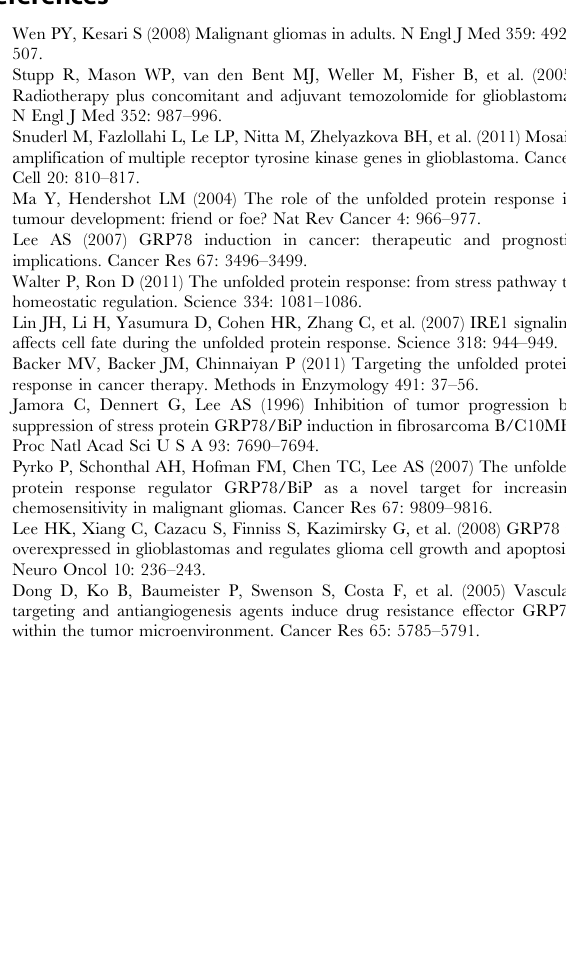
Figure S3 Effect of EGF SubA and SubA on cell pro- liferation. The influence of EGF-SubA and SubA on cell proliferation in the described cell lines and conditions were measured in real time by the xCELLigence system. Cells were seeded in proprietary plates and exposed to 1 pM of SubA, EGF- SubA, or PBS alone. Cell proliferation was monitored every 15 minutes and the results are represented as the mean of quadruplets for each assay condition. This figure is a representative of three independent